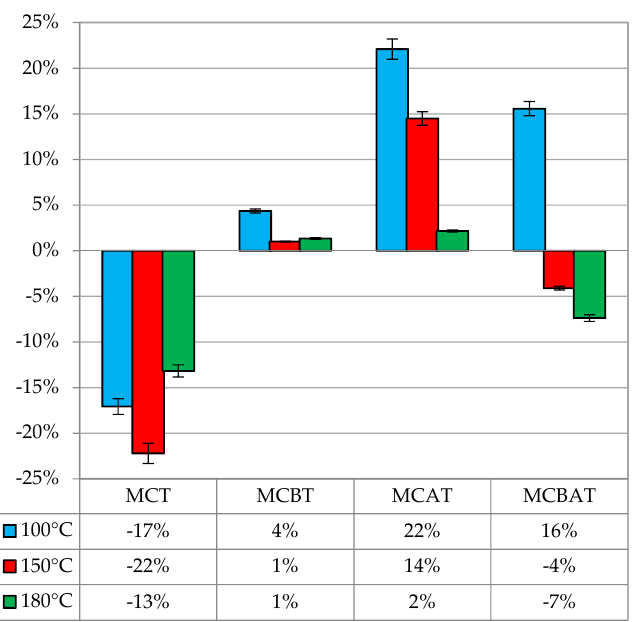
Figure 4. The compressive strength of the mixes compared to the reference mortar specimens maintained at room temperature.